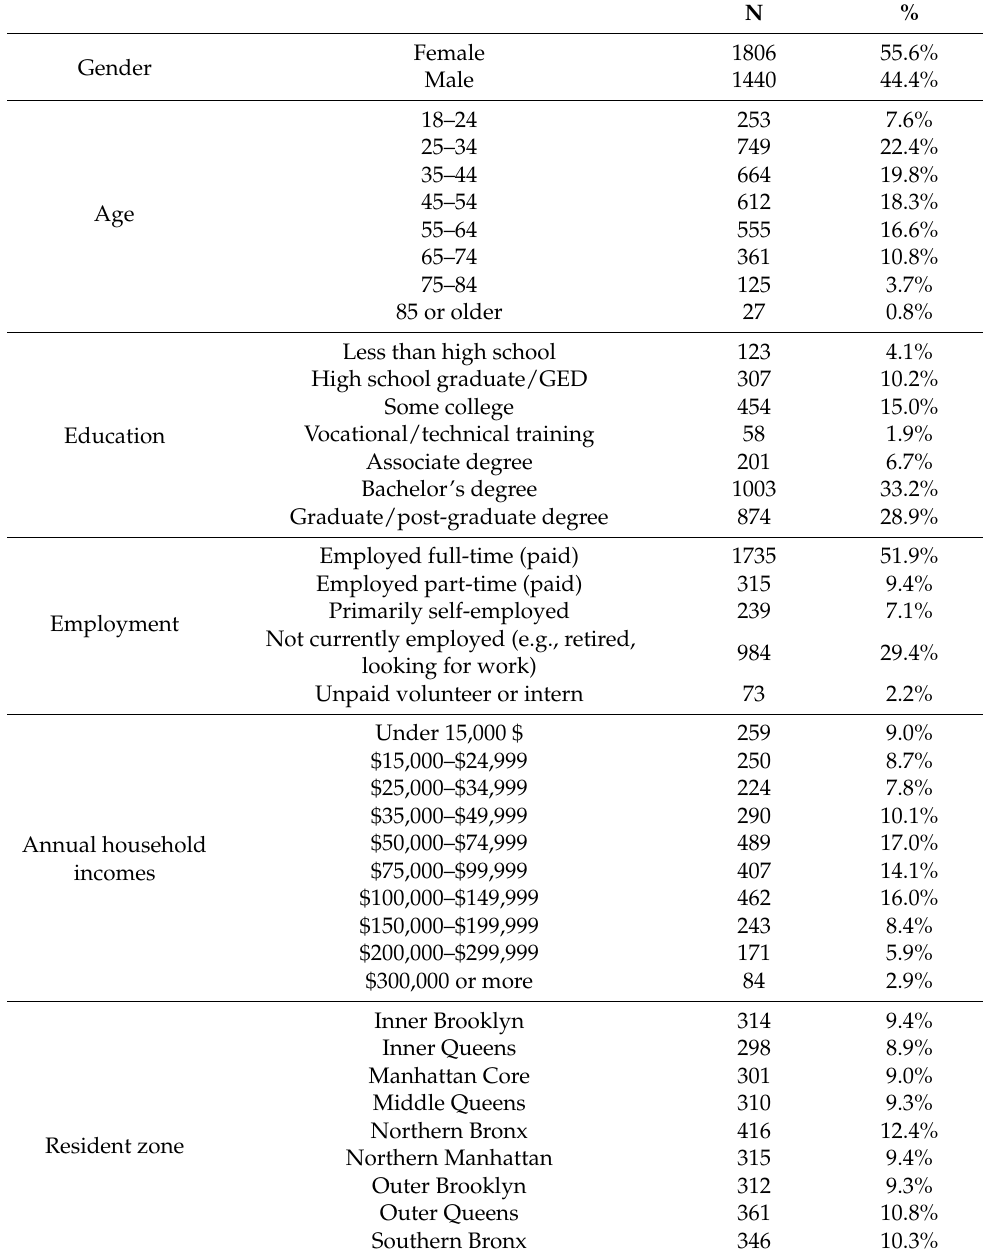
Table 1. Demographic profile of the